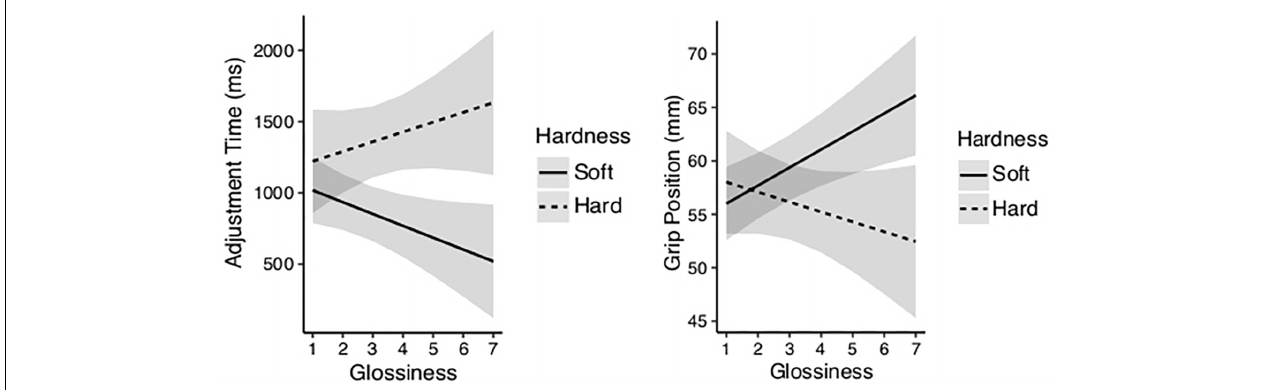
FIGURE 8 | (left) For the first block of trials, the estimated adjustment time based on LMM analysis for the interaction between the properties glossiness and hardness as based on the pre-reaching ratings. The figure shows cups assigned hard properties to have longer adjustment time than cups assigned soft properties, and that distinction to increase the shinier the cups got rated. (right) Estimated grip position based on LMM analysis for the same rated properties. The figure shows grip position on rated soft cups to move upwards in vertical direction the shinier they got rated, and move downwards for rated hard cups the shinier they got